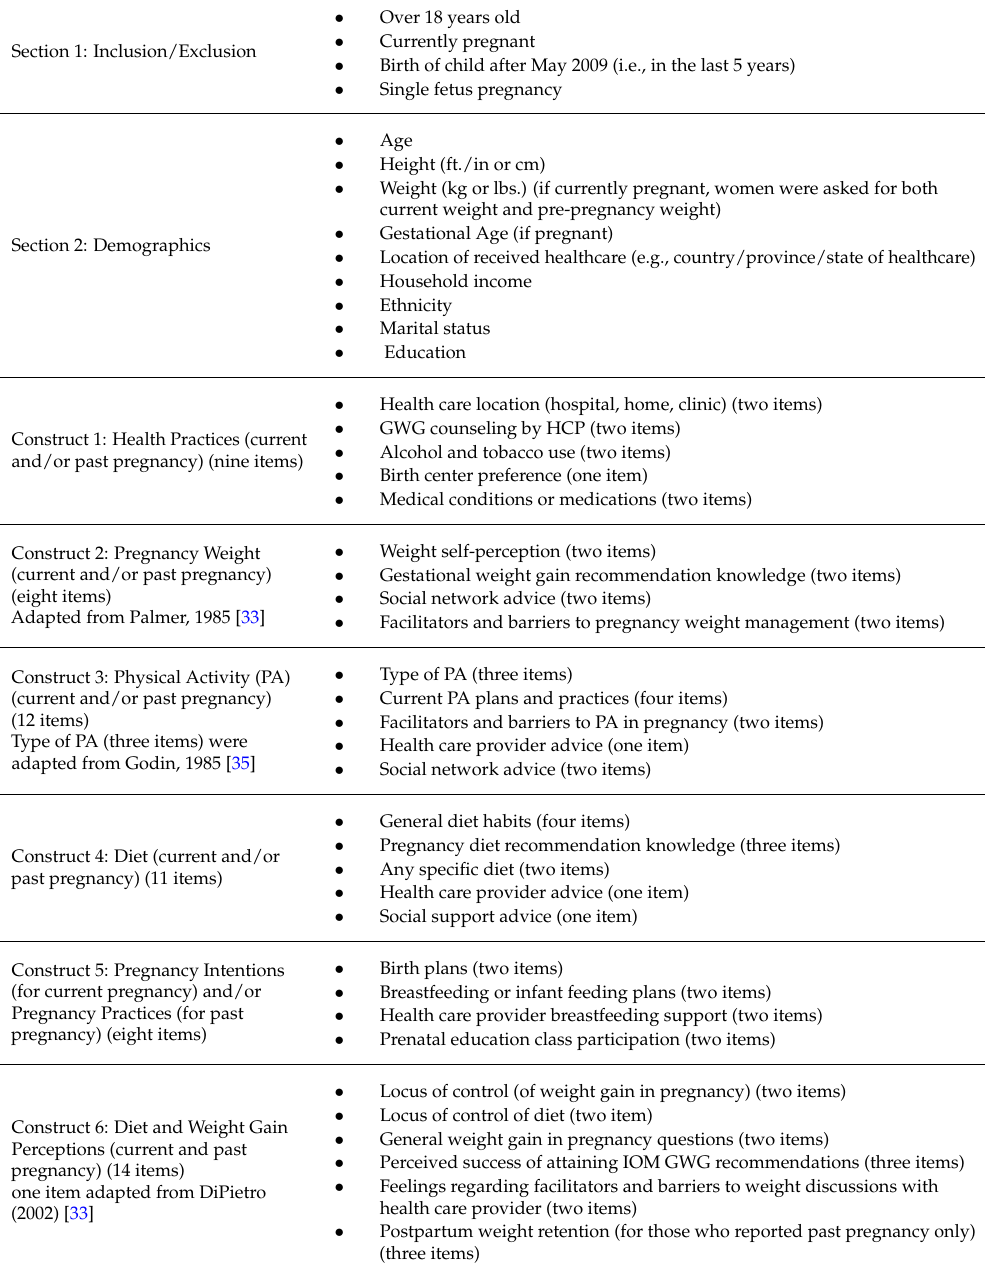
Table 1. Questionnaire section and construct